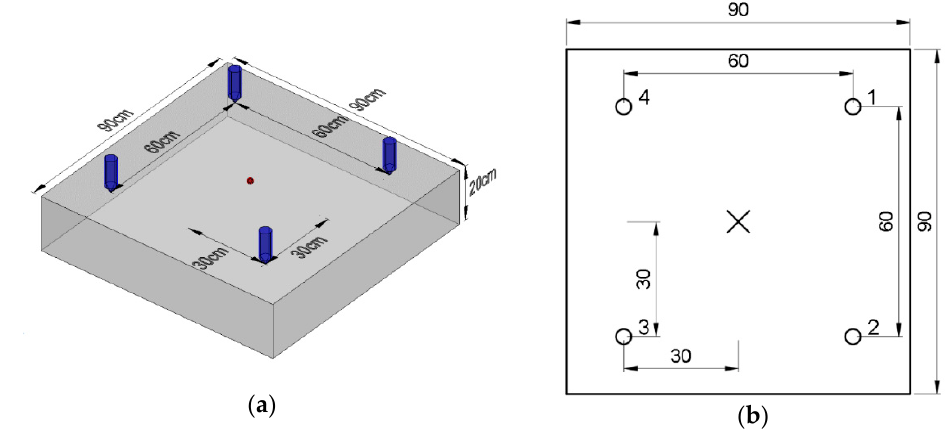
Figure 5. Square measurement system layout: ( a ) isometric and ( b ) top views.